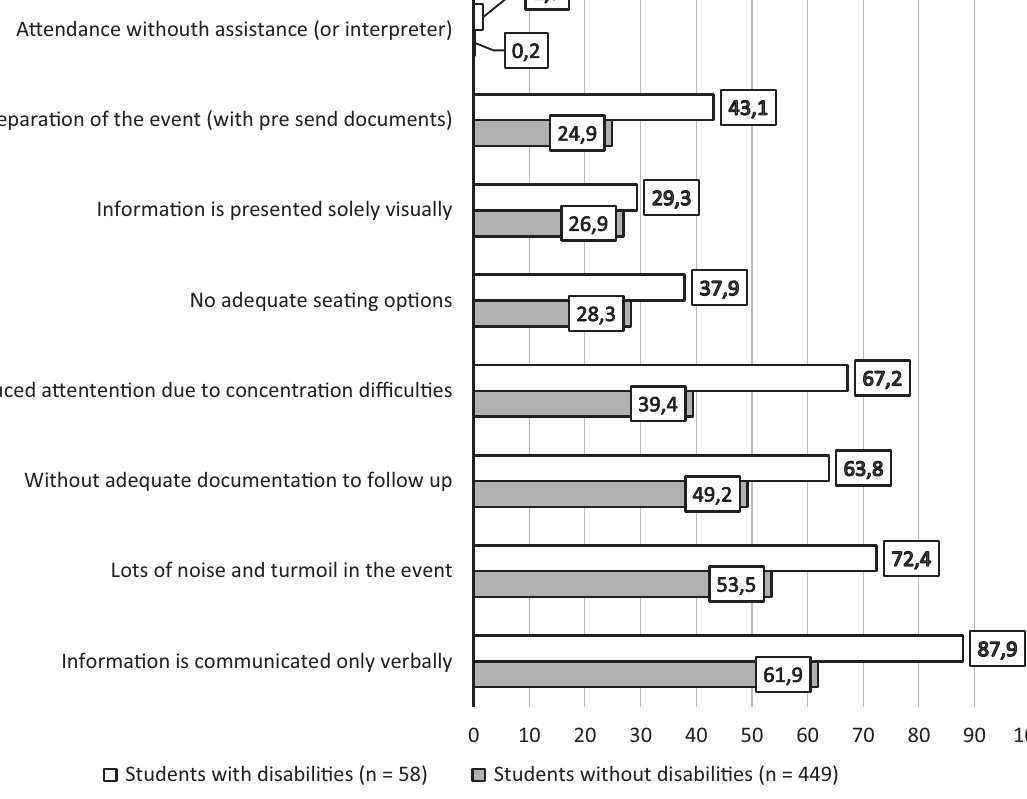
Figure 1. Information loss when participating (percentage; all students, multiple answers possible). Question: When par‐ ticipating in courses, I lose information if… problems better (CrV 0,160, p = 0,008, if differentiated between different impairment types; Degree